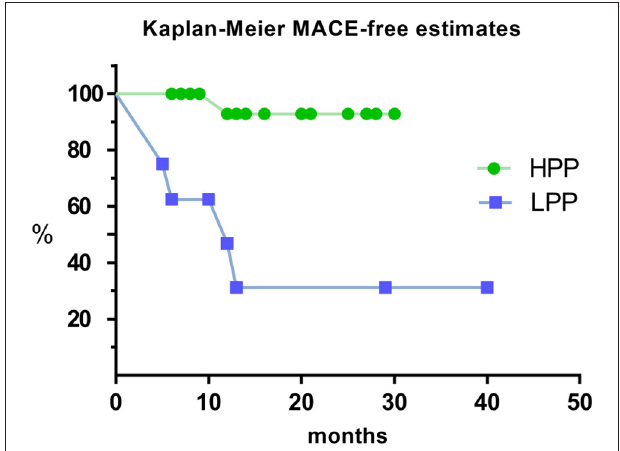
FIGURE 6 | Kaplan–Meier estimate for MACE of HPP and LPP. MACE: composite endpoint of readmission for HF and cardiac mortality. MACE, major adverse cardiovascular events; HPP, high pacing proportion; LPP, low pacing